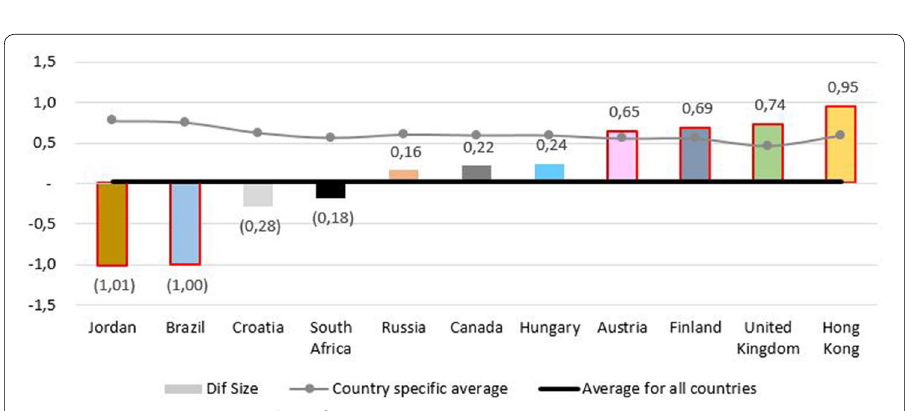
Fig. 11 DIF size: question